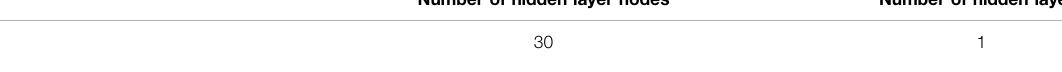
Structural parameters of the BPNN prediction model Learning